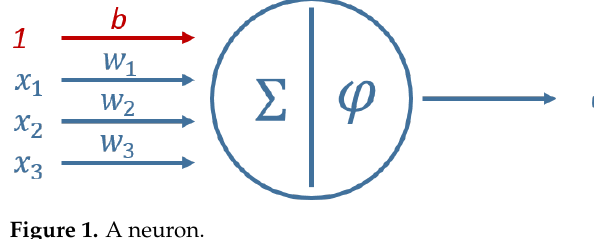
Figure 1. A neuron.